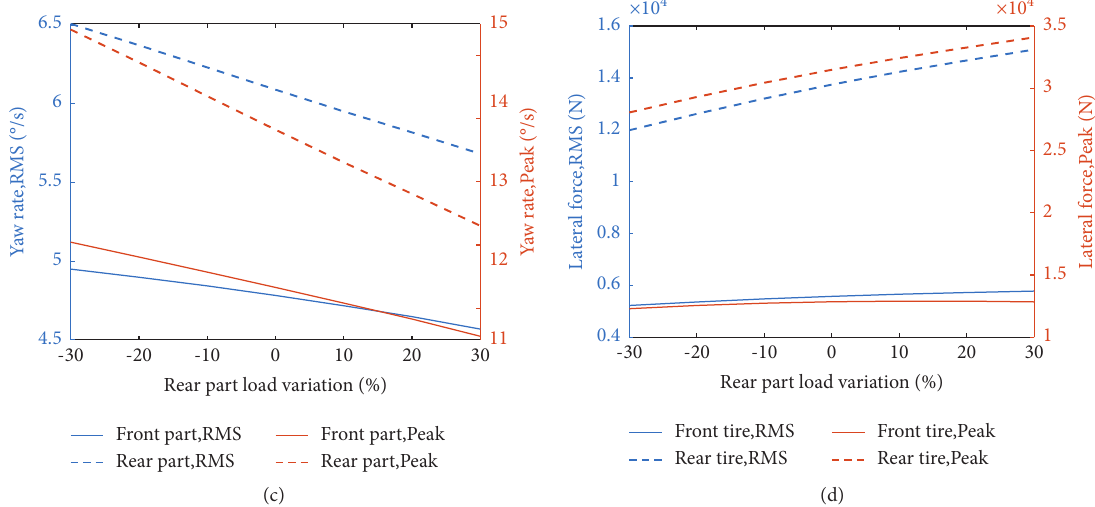
Figure 10: Vehicle performance of the rear part load variation. (a) RMS and peak value of tire sideslip angle. (b) RMS and peak value of vehicle sideslip angle. (c) RMS and peak vehicle yaw rate. (d) RMS and peak value of lateral force.